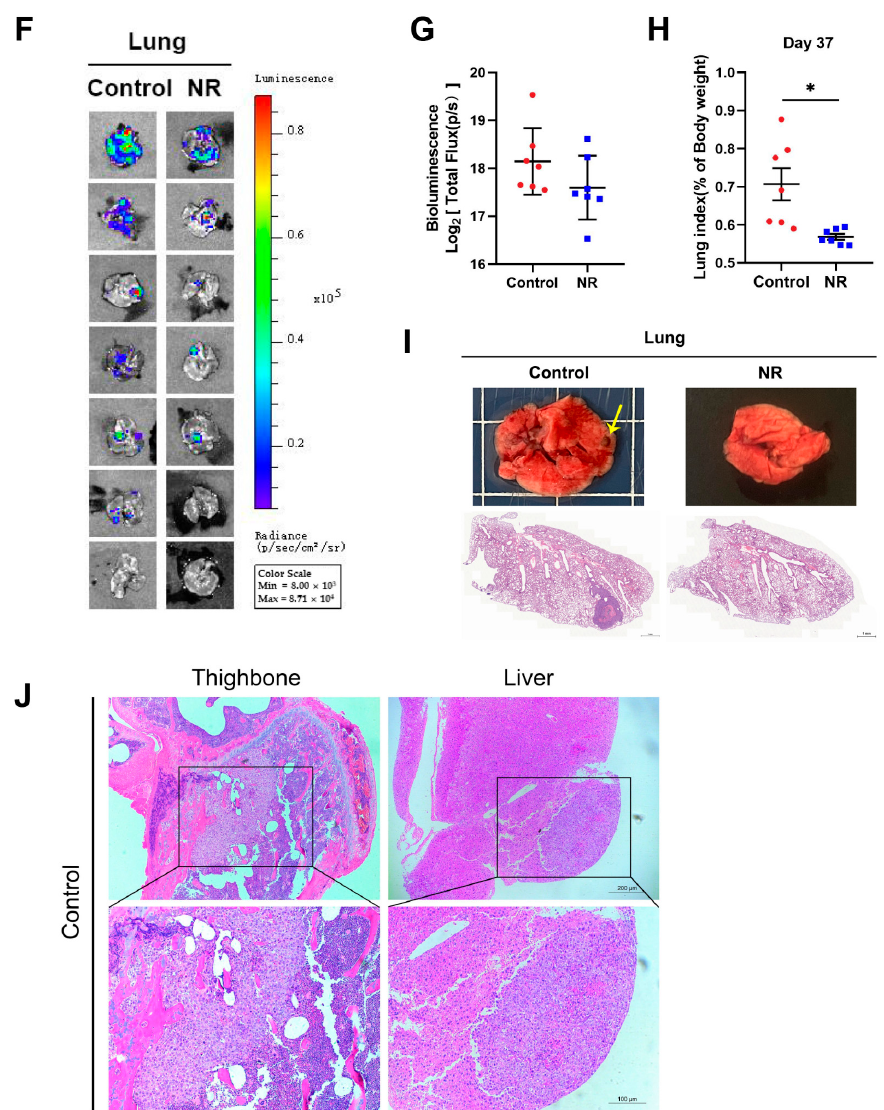
Figure 4. NR supplementation inhibited hematogenous multi-organ metastasis of HCC cells in mice. ( A ) Schematic of the hematogenous metastatic neoplasm model. ( B ) Trends in body weight of mice during the intervention. ( C ) Differences in weight changes between NR and control group after 37 days of intervention. Dotted line represented the line (y = 0). ( D ) The activity of HepG2-GL cells in vivo throughout the intervention, quantified by bioluminescent signals (Total Flux, p/s) of the whole mice body. Dotted line showed the bioluminescence signals on day 0. ( E ) The metastasis of HepG2-GL cells in vivo after 37 days of intervention shown by noninvasive bioluminescence imaging. ( F ) The metastasis of HepG2-GL cells in lungs after 37 days of intervention shown by bioluminescence imaging. ( G ) Quantification of the image in ( F ) with bioluminescent signals (Total Flux, p/s) of the lungs. ( H ) Lung-to-body weight ratios at the endpoint of the intervention. ( I ) Representative images of lungs dissected from mice per group. In the upper row, the arrow points to the macroscopic tumor nodule. In the lower row are scanning pictures of H&E staining sections, scale bars: 1 mm. ( J ) Representative H&E staining section of tumor metastasis to the bone and liver of mouse in the control group; scale bars: 200 µm (top row), 100 µm (bo tt om row). n = 7/group; Red dots: control mice; blue dots: NR-treated mice. * p < 0.05 compared to the control group. p -values were calculated using two-way RM ANOVA ( B ), unpaired t test and Welch’s correction ( C , H ), two-way RM ANOVA and Sidak’s multiple comparisons test ( D ), and Mann – Whitney test ( G ). NR, nicotinamide riboside.